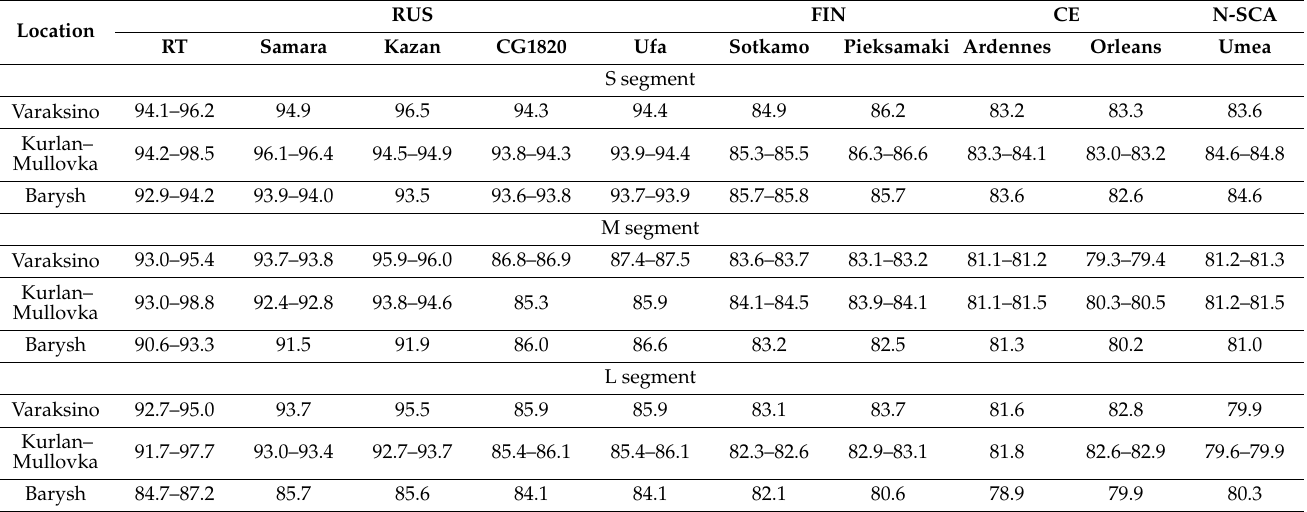
Table 3. Percentage identities between ULR and UR PUUV complete CDS segment S, partial M, and L sequences identified in different trapping sites and belonging to RUS, FIN, CE, and N-SCA genetic